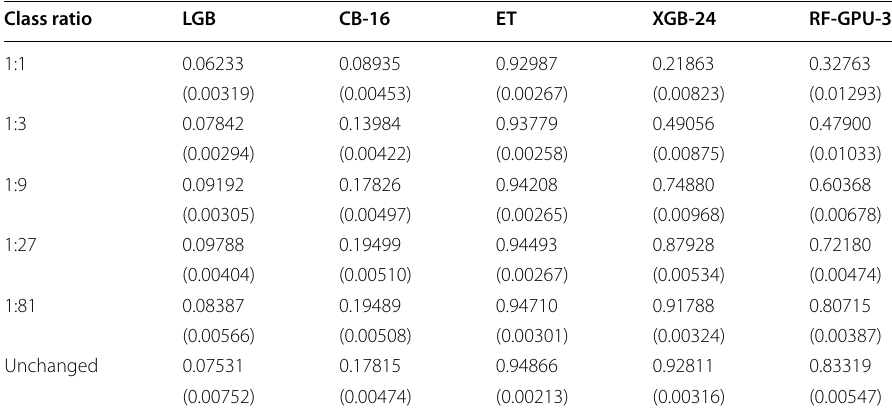
Table 6 DMEPOS mean and standard deviation of AUPRC with varying levels of RUS (10 iterations of fivefold cross-validation)